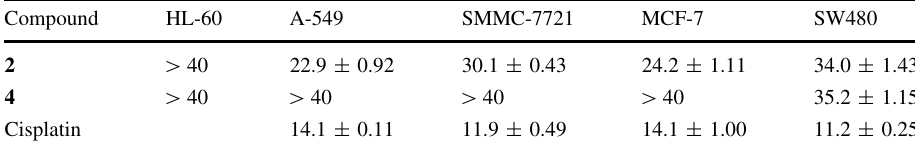
Table 3 Cytotoxicity of compounds 2 and 4 against five human cancer cell lines (IC 50 ± SD in l